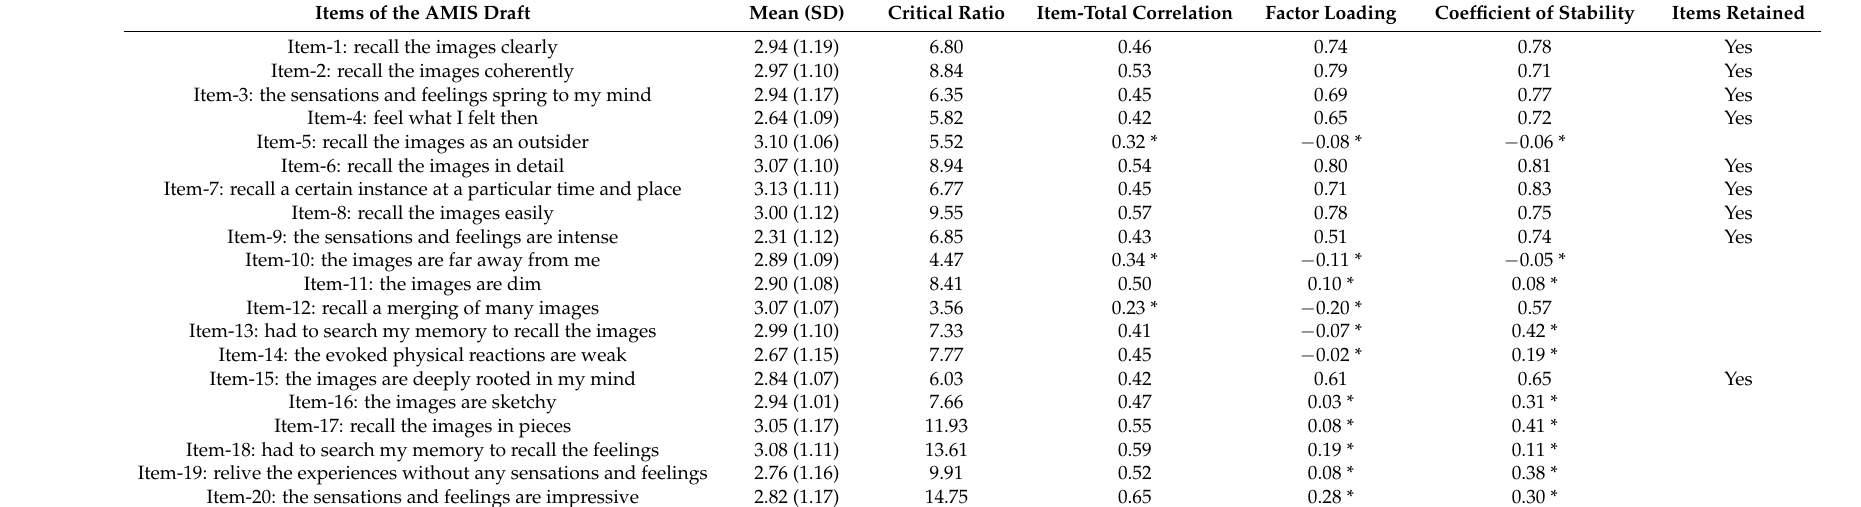
Table 2. Item analysis of the draft Addiction Memory Intensity Scale (AMIS; n =